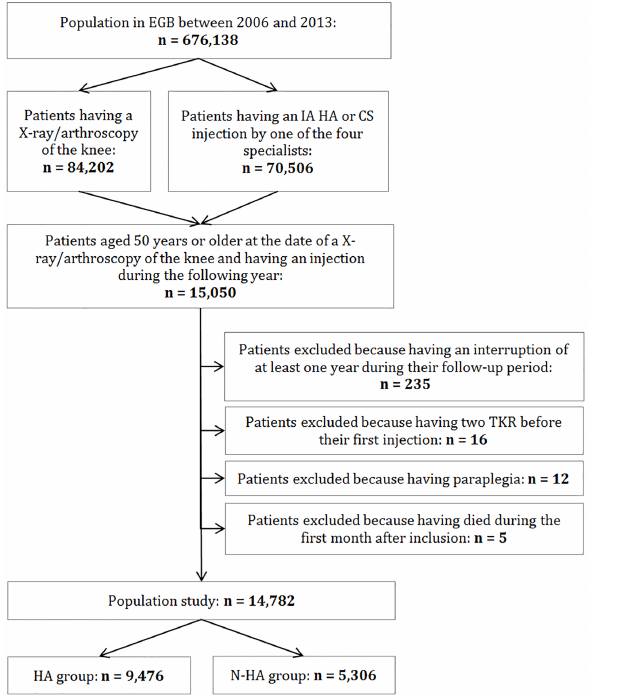
Fig 1. Flow-chart of patients’ selection. IA: intra-articular, HA: hyaluronic acid, CS: corticosteroids, TKR: total knee replacement. HA group: patients who receivedat least one IA HA injectionduringtheir follow-up period, N-HA group: patients who received only CS as IA injections.The four specialistsare rheumatologist, orthopedicsurgeon, physicalmedicineand rehabilitation practitioner and generalpractitioner.